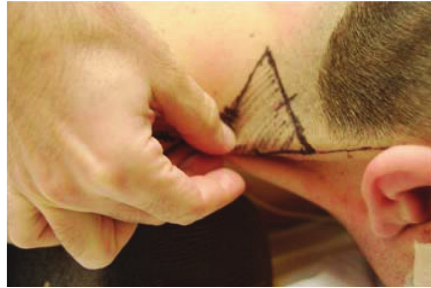
Figure 1: A pinch test of the skin overlying the trapezius muscle was used to determine the excess.